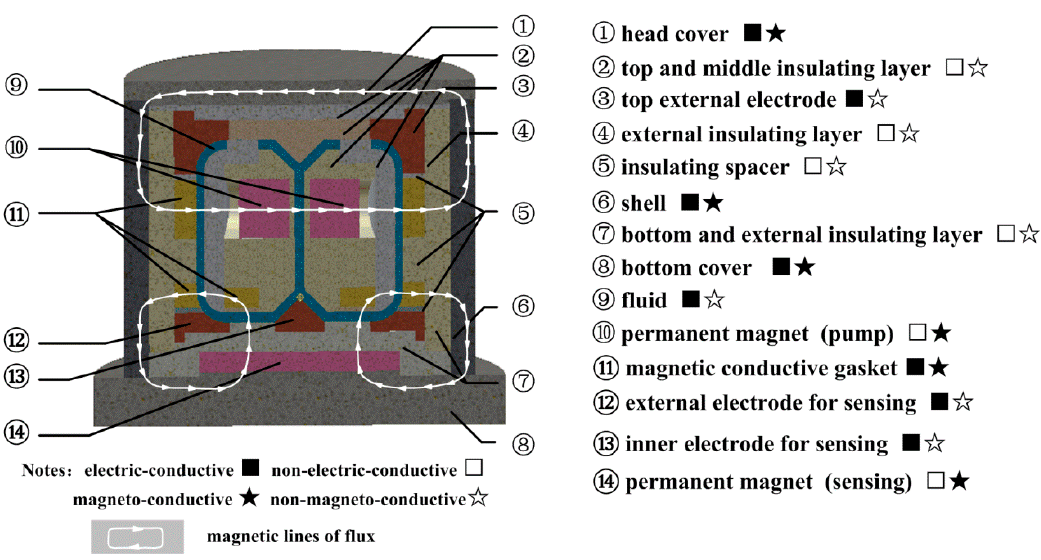
Figure 4. Schematic diagram of the designed C-MHD ARS in simulation and experiment.